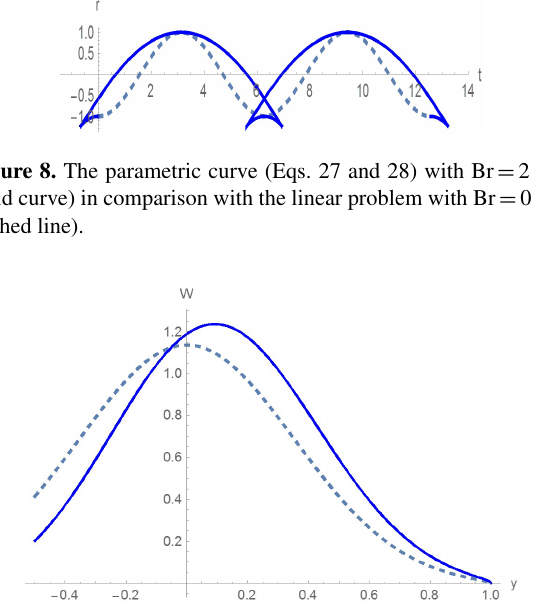
Figure 9. The probability density function at Br = 2, constructed by Eqs. (42) and (43) (the solid line) in comparison with the linear distribution (Eq. 43) (the dotted line) ( A s /A max = 0 .